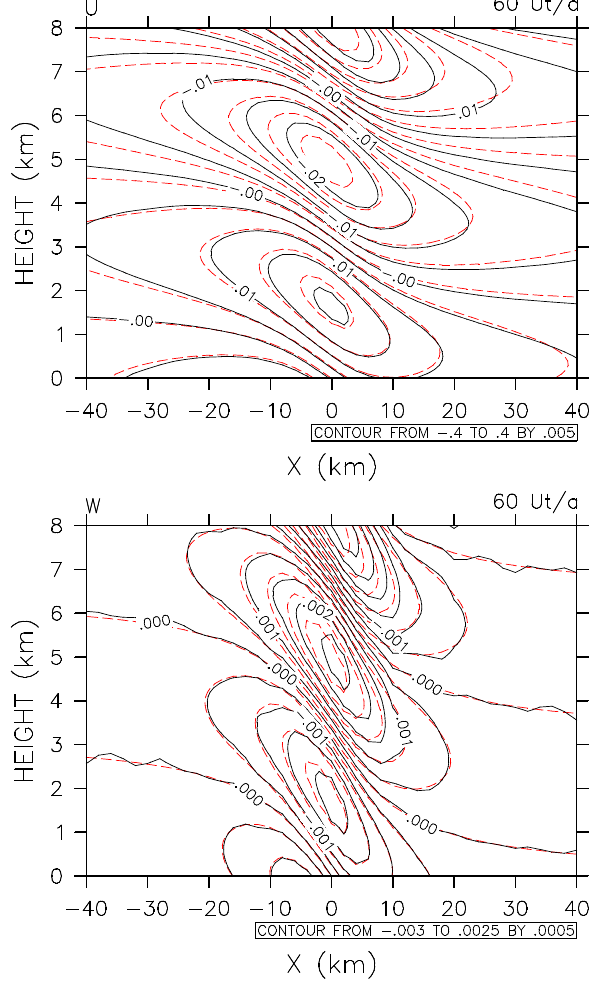
Figure 2. Steady-state flow of (top) horizontal velocity (ms − 1 ) and FIG. 2. Steady-state flow of (top) horizontal velocity (m/s) and (bottom) vertical velocity 2 (bottom) vertical velocity (ms − 1 ) over 1m high mountain at nondi- = 60 with a grid resolution of (cid:49) ¯ x = 2km using mensional time ¯ ut a (m/s) over 1-m high mountain at nondimensional time fifth-order basis polynomials per element and (cid:49) ¯ z = 375m. The nu- merical solution is represented by solid lines and the analytic solu- tion is represented by dashed lines. 2x ∆ = km using 5th-order basis polynomials per element and 375z ∆ = m. The numerical 4 solution is represented by solid lines and the analytic solution is represented by dashed lines. 5